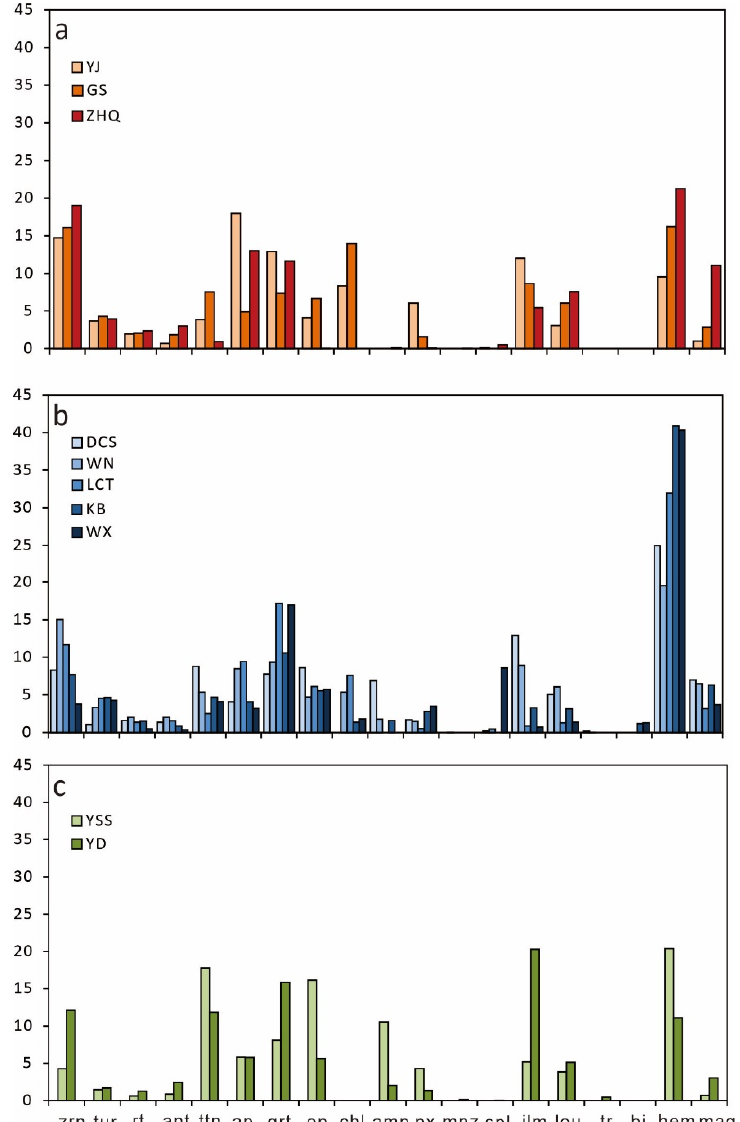
Figure 5. Average heavy mineral assemblages of sandstones from each location. ( a ) The heavy mineral assemblages of sandstone samples from Yuejin, Gasi, and Zhahaquan. ( b ) The heavy mineral assemblages of samples from Dongchaishan, Wunan, Lvcaotan, Kunbei, and Wanxi. ( c ) The heavy mineral assemblages of samples from Youshashan and Yingdong. The data and abbreviations of heavy minerals are shown in Table S1.